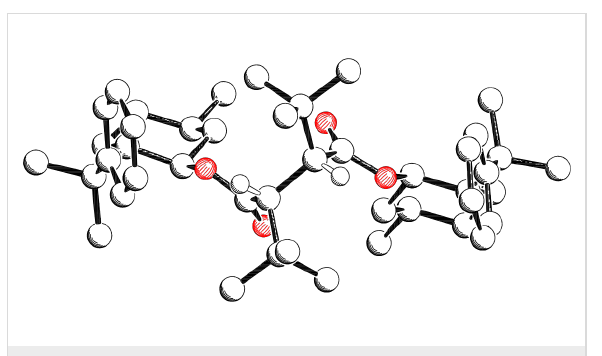
Figure 5: Crystal structure of major diastereomer 29a .